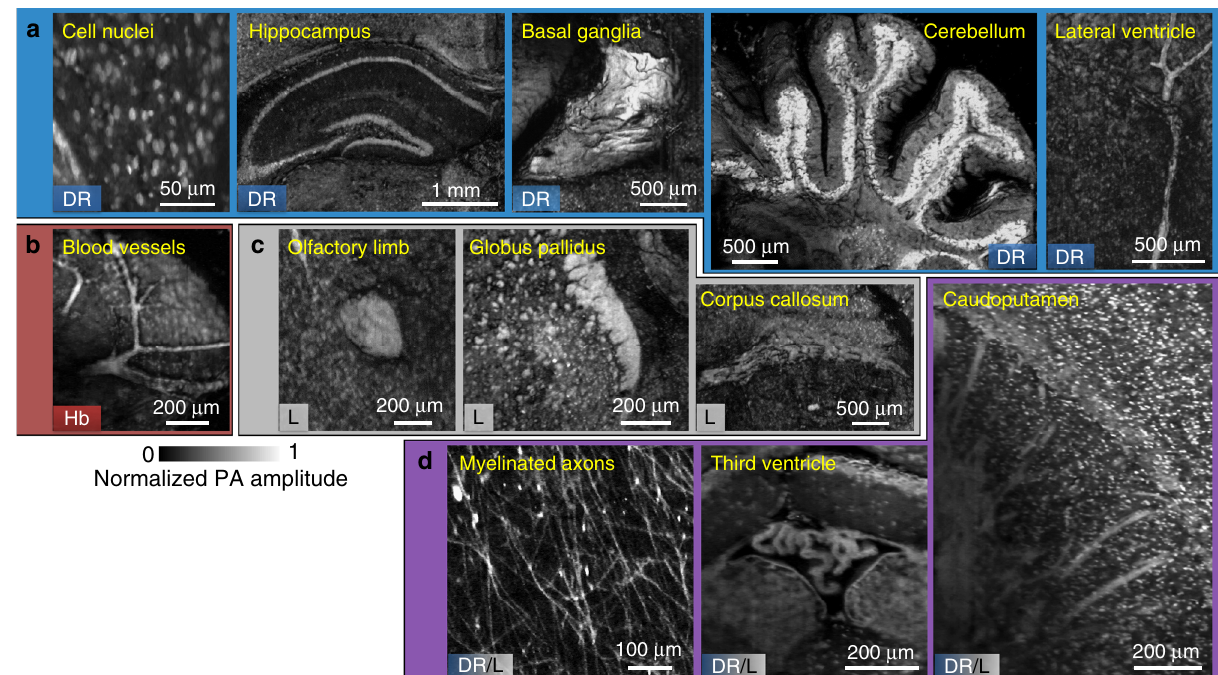
Fig. 4 Image gallery of features extracted from label-free mPAM images of four unstained mouse brains embedded in agarose blocks. All features are shown in coronal view. Collections of images showing the biomolecules that provide absorption contrast due to a DNA/RNA (DR), b hemoglobins (Hb), and c lipids (L). d Images of myelinated axons, third ventricle, and caudoputamen due to both DNA/RNA and lipids